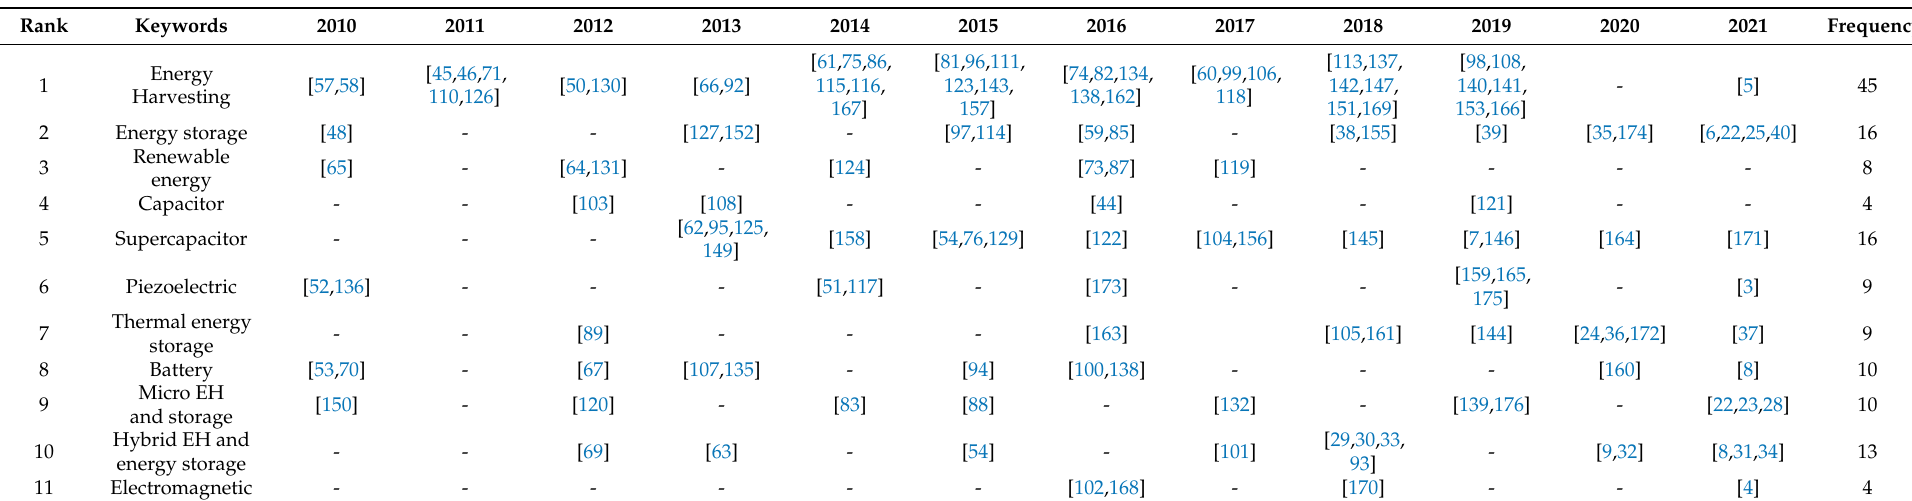
Table 2. 11 most-selected keywords utilized in numerous manuscripts from 2010 to